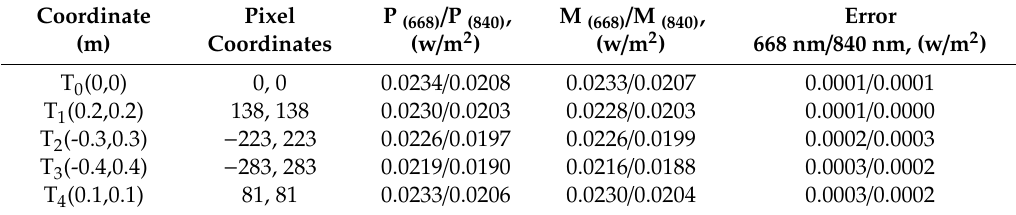
Table 7. Predicted light intensity and measured light